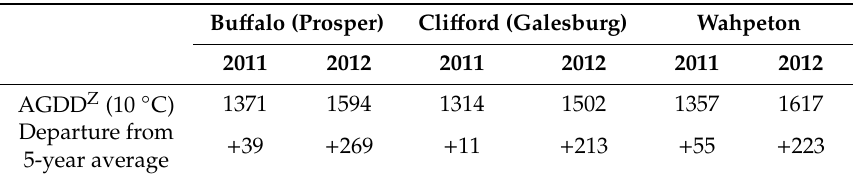
Table 2. Accumulated growing degree days data (base 10 ◦ C) during 2011 and 2012 for 1 April to 30 September growing seasons collected from NDAWN weather stations’ (in parenthesis) nearest vineyard locations and the comparison to the 5-year average.